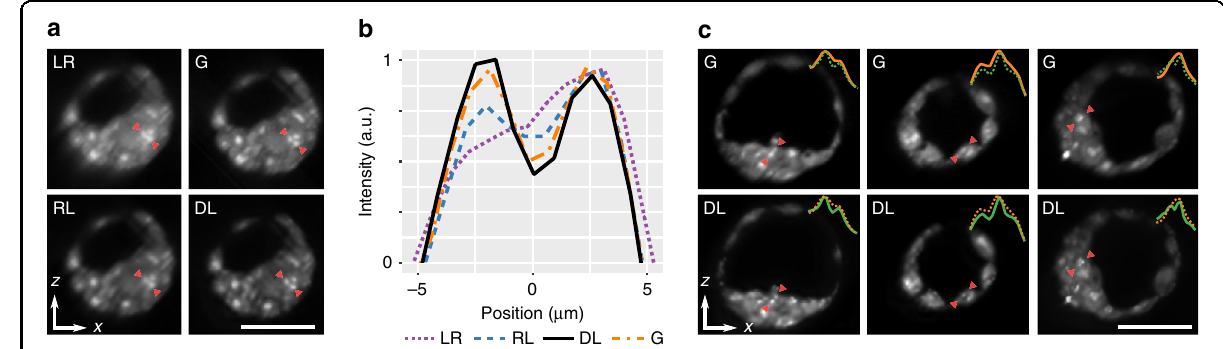
Fig. 4 Cross-sectional images of mouse blastocyst-stage embryos. a Airy LSM image (LR) is deconvolved with Richardson – Lucy (RL) and deep- learning (DL) deconvolution, and compared with a Gaussian LSM (G). b Intensity pro fi les marked by the red arrows in ( a ). c Cross-sections of blastocyst-stage embryos imaged with a Gaussian LSM (G) and compared to an Airy LSM with deep-learning deconvolution (DL). Pro fi les marked by the red triangles are displayed as insets. Scale bar is 50 μ